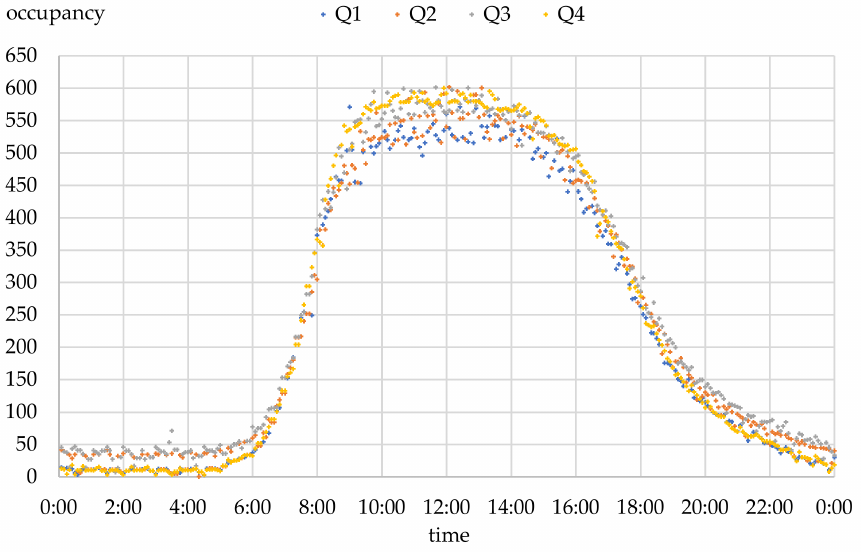
Figure 5. Thursday arrivals / departures ([33], calculated by